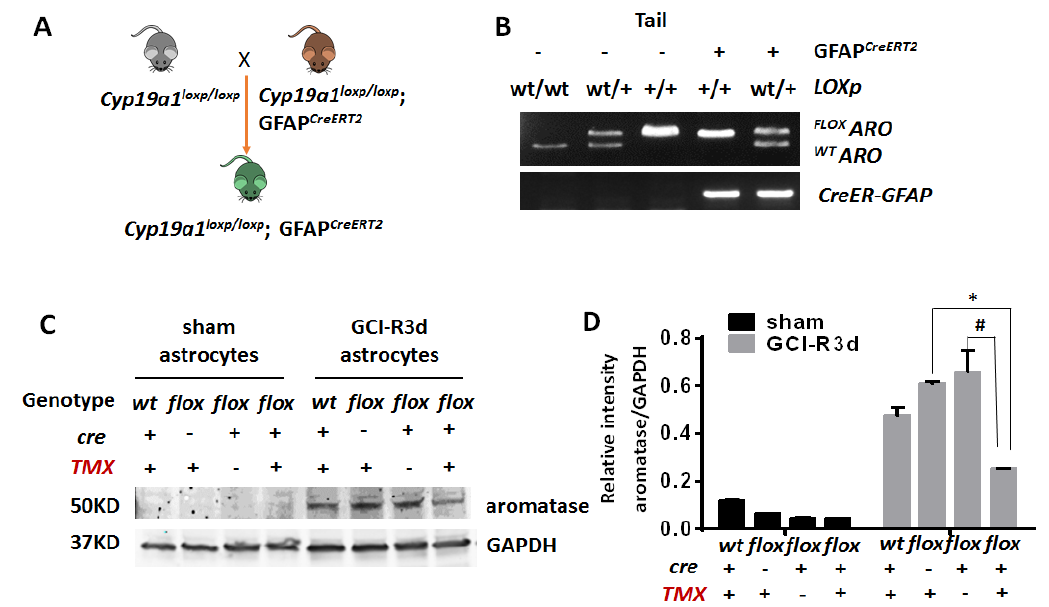
Figure 1. Creation and assessment of GFAP-ARO-iKO mice. ( A ). Breeding strategy represented in a diagram. ( B ). Tail DNA PCR confirmation of bitransgenic GFAP-ARO-iKO mice expressing GFAP-CreER and homozygous loxp CYP19a1 . ( C , D ). Verification of the knockout of aromatase in astrocytes in the Cyp19a1 loxp/loxp ; GFAP CreERT2 mice. Western blot ( C ) on purified astrocytes lysate isolated from sham or GCI-R3d mouse hemisphere. Densitometry analysis ( D ) demonstrates that the TMX-induced aromatase knockout animals at R3d showed a considerable reduction in aromatase expression of the astrocytes ( D ). n = 6–8 animals/groups. # p < 0.05 compared to TMX ( − ),